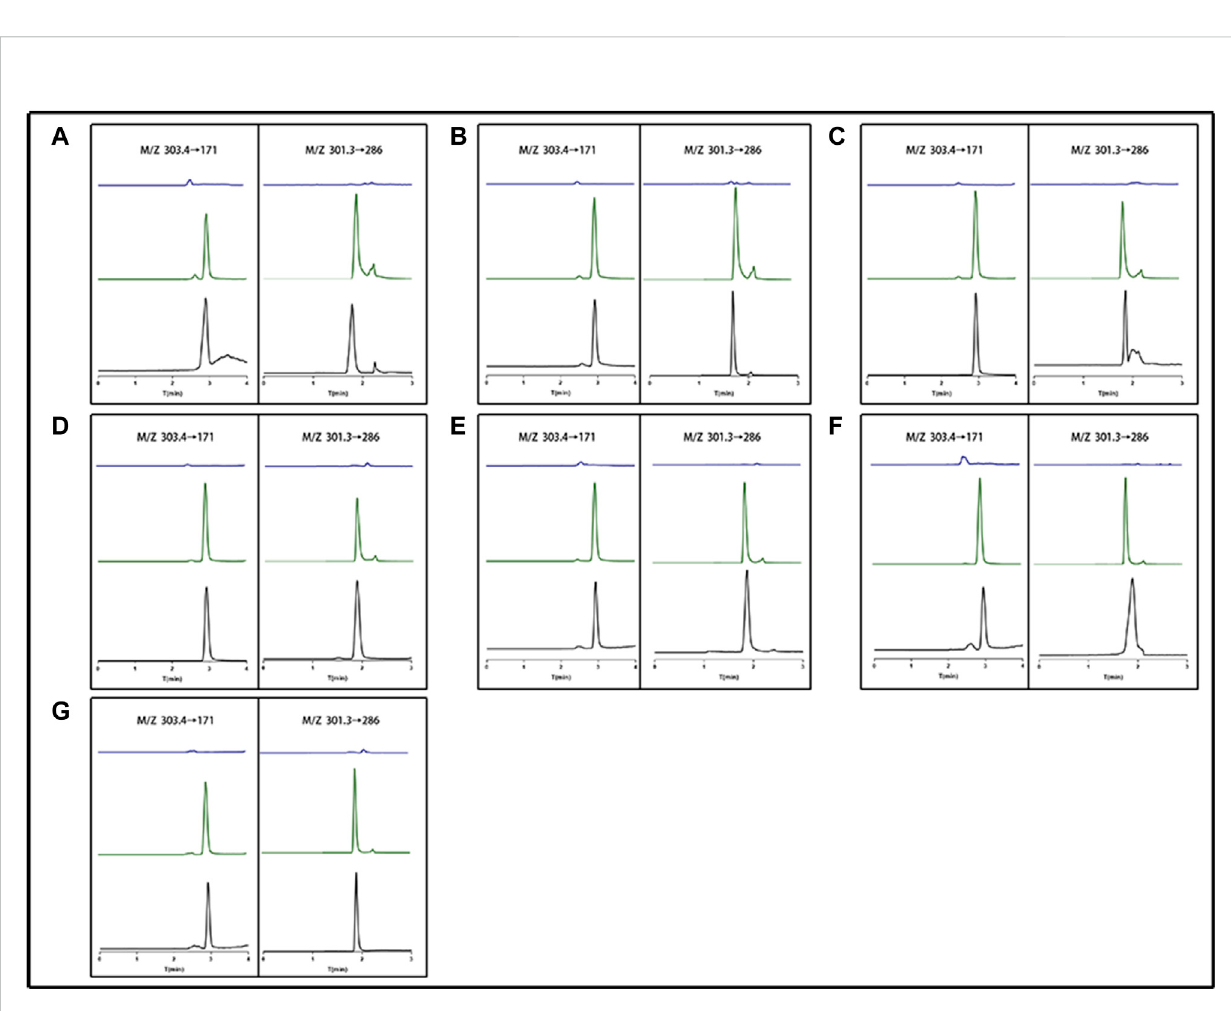
FIGURE 3 The representative chromatogram of evodiamine (EDM) and dehydroevodiamine (DEDM). (A) Heart; (B) Liver; (C) Spleen; (D) Lung; (E) Kindy; (F) Brain; (G) Plasma; Theleft side(M/Z303.4 → 171)represents EDM; Therightside(M/Z301.3 → 286) represents DEDM; bluefor blanktissue homogenate or blank plasma; Green for standard plus tissue homogenate or plasma; black for tissue homogenate or plasma sample.